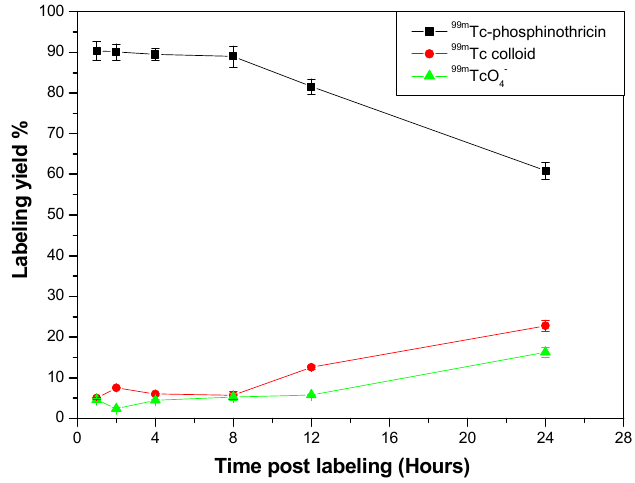
Figure 12. In vitro stability of 99m Tc-phosphinothricin complex.